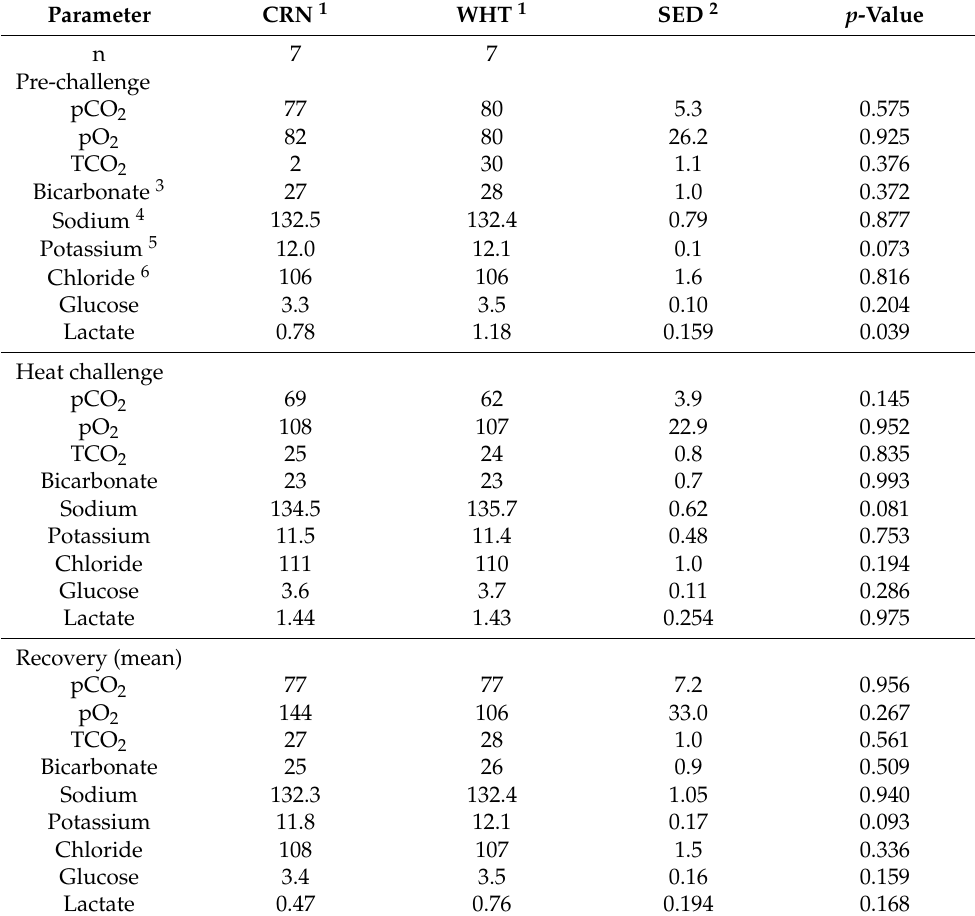
Table 5. Mean blood-gas partial pressures (mmHg) of carbon dioxide (pCO 2 ) and oxygen (pO 2 ) and blood concentrations (mmol/L) of total carbon dioxide (TCO 2 ) and selected analytes. Parameter CRN 1 WHT 1 SED 2 p -Value n